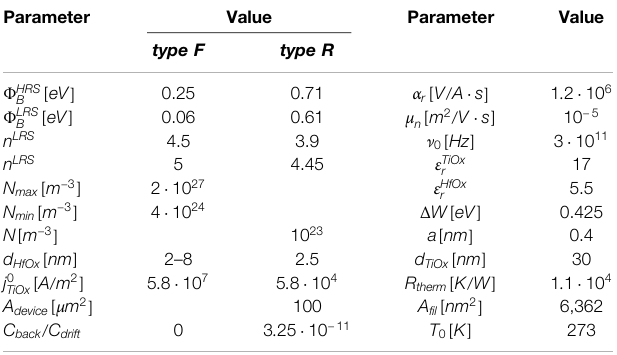
TABLE 1 | Simulation Parameter.